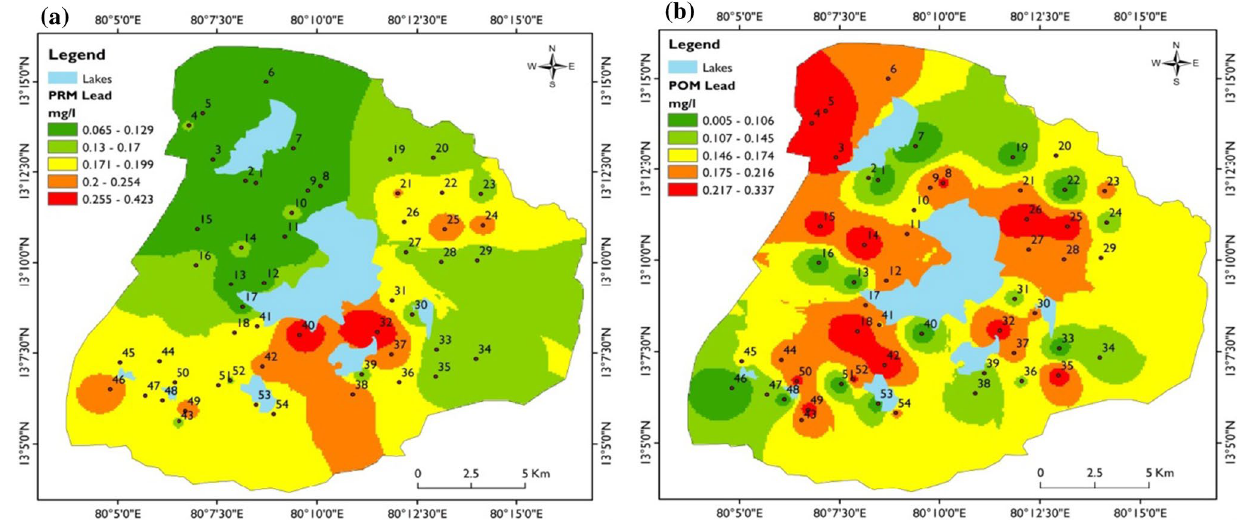
Fig. 7 a , b Spatial variation of Pb in the groundwater for pre-monsoon and post-monsoon,